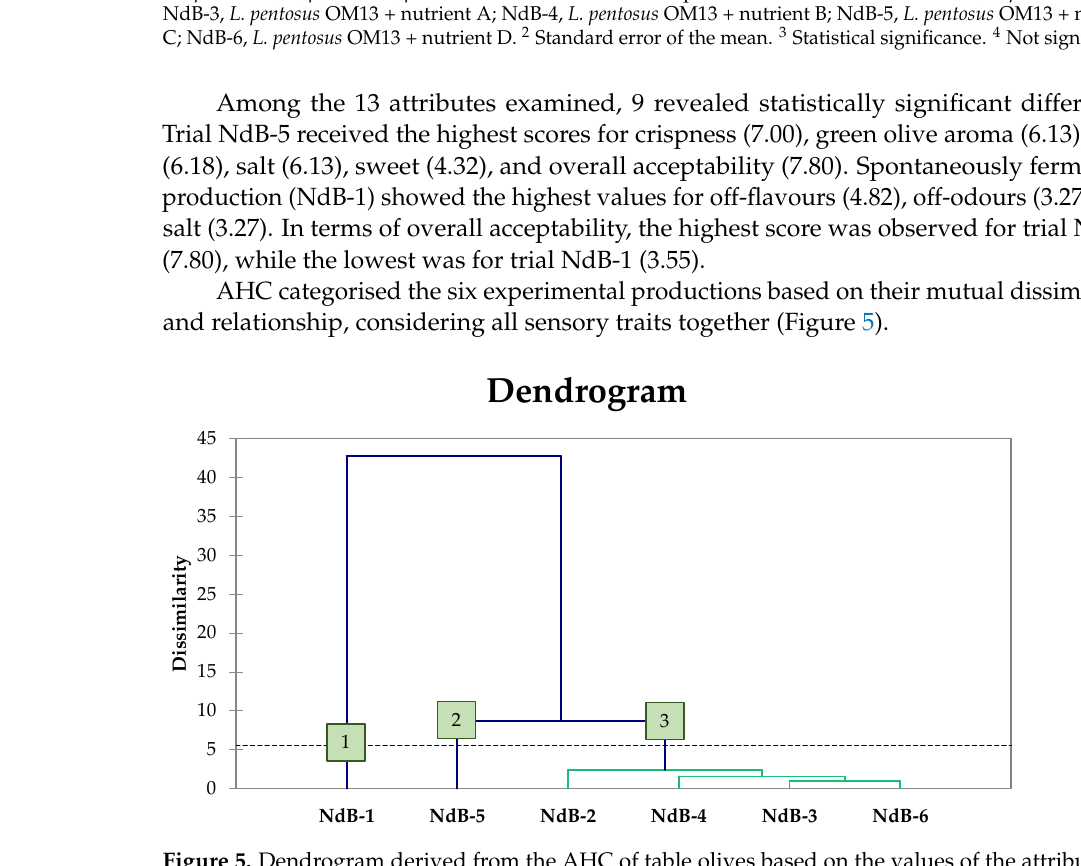
Data in the same line followed by the same le tt er are not signi fi cantly di ff erent according to